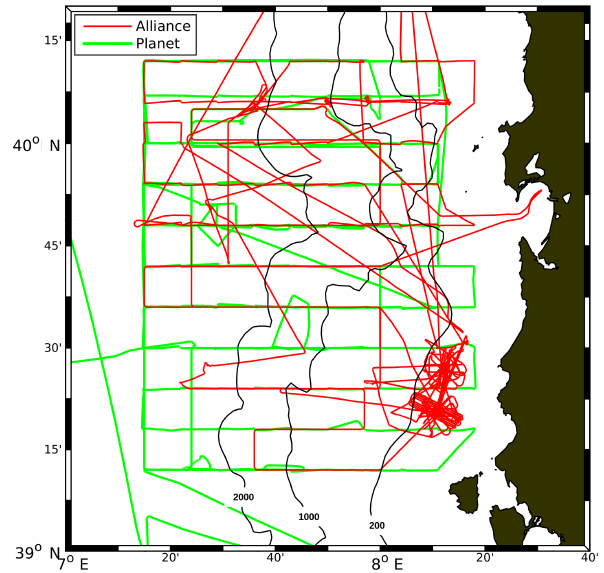
Figure 10. Ship tracks of Alliance and Planet . Black lines indicate water depth